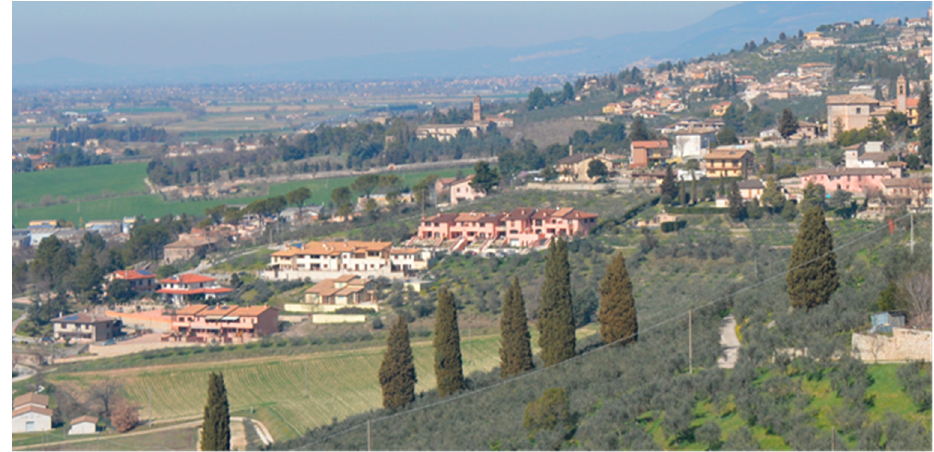
Figure 5. Landscape visual detractor.